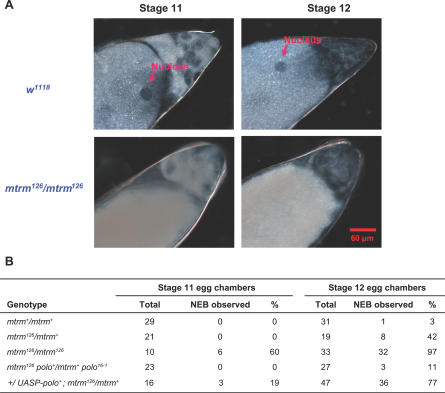

mtrm Causes Precocious NEB(A) Representative examples of NEB in stage 11 and 12 egg chambers for wild-type (w1118) and mtrm126 homozygotes. NEB in wild-type oocytes occurs at stage 13. The nucleus is still present (seen as a dark mass by phase contrast microscopy) at stage 11 and stage 12 in wild-type. mtrm homozygotes show precocious NEB (absence of the dark mass) that can occur prior to stage 11. Scale, 60 μm.(B) Summary of NEB in stage 11 and stage 12 egg chambers for wild-type (w1118), mtrm heterozygotes (mtrm126/+), mtrm homozygotes (mtrm126/ mtrm126), double heterozygotes for both mtrm, polo (mtrm126 +/+ polo16–1), and over-expression of Polo in mtrm heterozygotes (+/UASP-polo; mtrm126/+).